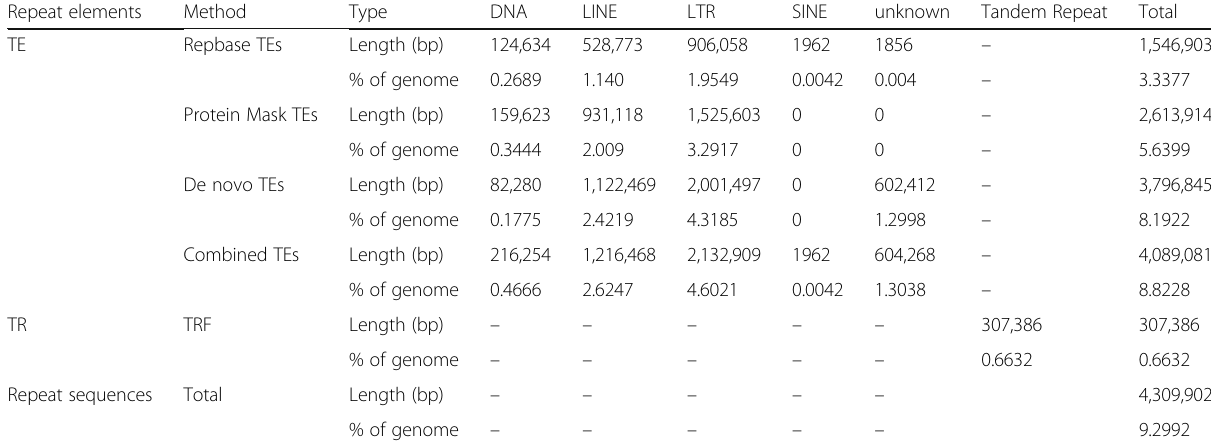
Table 2 The percentage of different types of repetitive elements in the Botryosphaeria dothidea LW-Hubei isolate genome Repeat